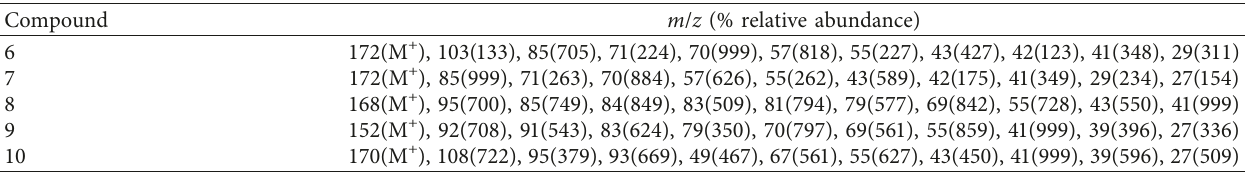
Table 16: Mass spectra of compounds 6–10 of whole plant n -hexane fraction of Achillea wilhelmsii (WHFAW). Compound